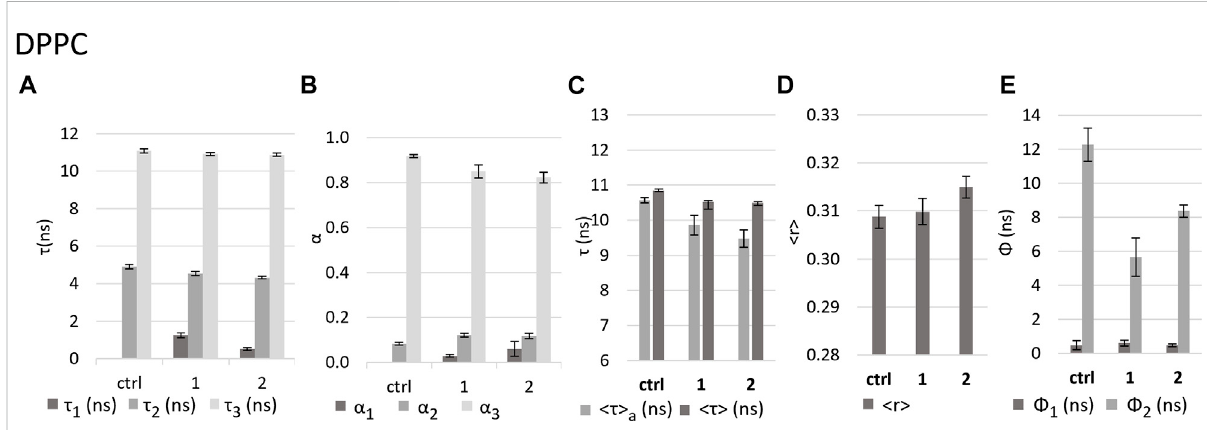
FIGURE 7 Effect of the complexes on DPPC LUVs as reported by DPH fl uorescence properties. Values in the absence (control - ctrl) and presence of complexes 1 and 2 in buffer 3 of (A) fl uorescence decay lifetime components; (B) amplitudes associated with each component; (C)